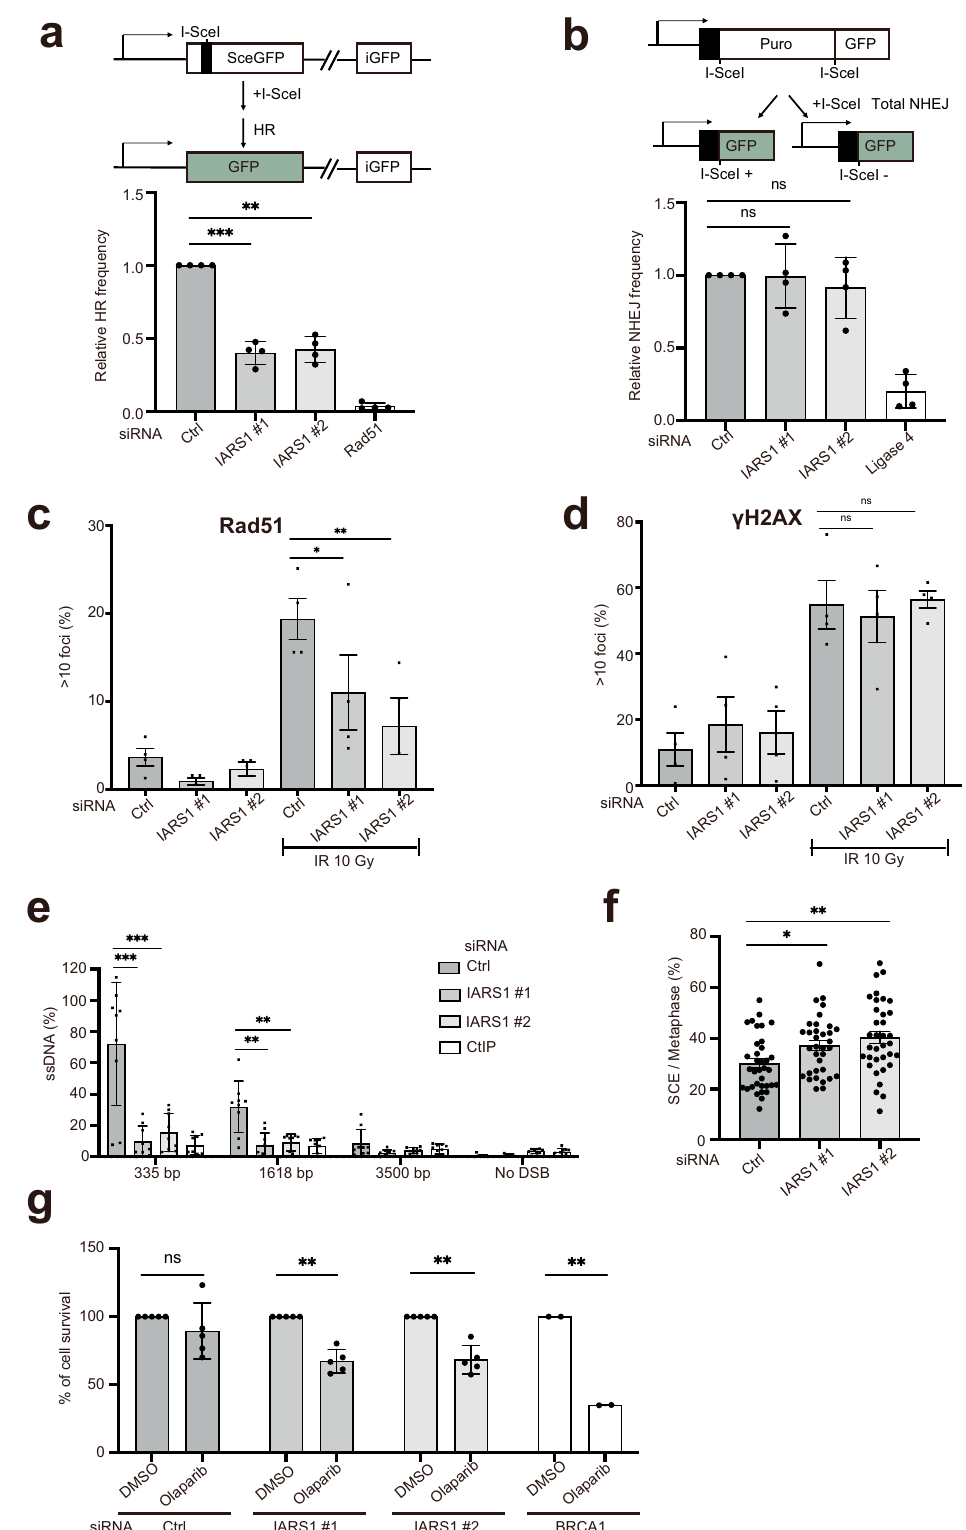
Af fi nity pull-down assay Human His-IARS1 or IARS1 Δ UBX2 protein was mixed with human GST- EARS1 or EARS1 Δ hairpin (residues 1 − 1015 and Δ 684 − 694) proteins at a ratio of 1:1.5, respectively, and incubated for 30 min at 4 °C. The pro- teinmixtures wereloaded onto Ni-sepharose beads for 2 hr at 4 °Cand eluted with 250mM imidazole prepared in His A buffer (20 mM Tris-